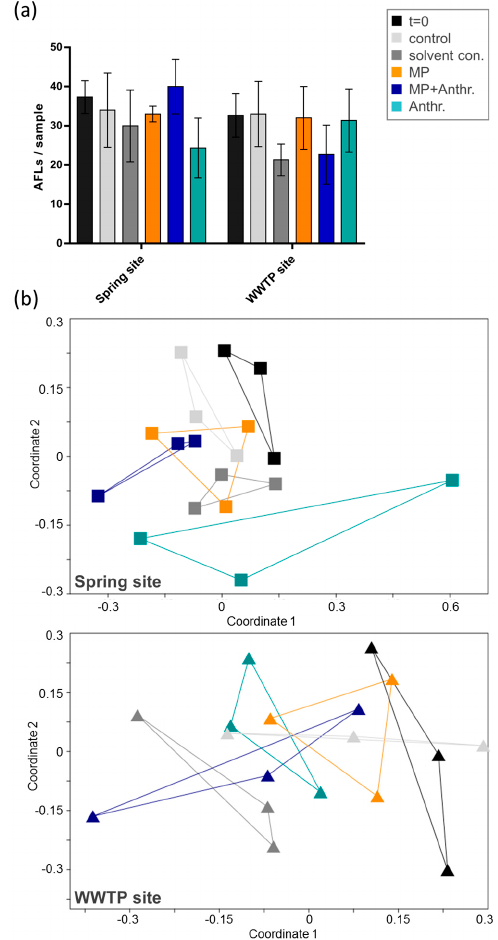
Figure 5. ( a ) Number of Automated Ribosomal Intergenic Spacer Analysis Fragment Length (AFLs) as indicator of bacterial richness in sediments from a spring site and downstream of a wastewater treatment plant (WWTP) before and after treatment with anthracene (Anthr.), polyethylene particles (MP) and anthracene-loaded polyethylene particles (MP + Anthr.). ( b ) The data set from ( a ) is represented in an nMDS graph based on Bray-Curtis similarities between samples, showing the shift in bacterial communities before and after